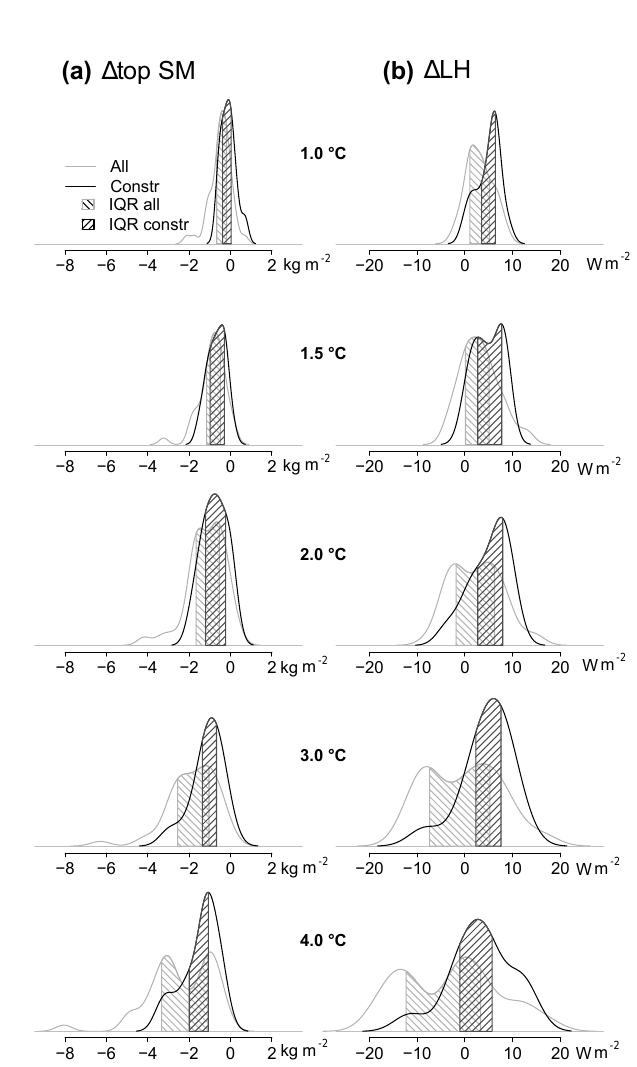
Figure A1. Distribution of top soil moisture (top SM, a ) and latent heat flux (LH, b ) changes according to global warming levels of 1, 1.5, 2, 3 and 4 ◦ C for the full (light grey) and the constrained ensemble (dark grey). The shaded area represents the interquartile range (IQR) of the two distributions.